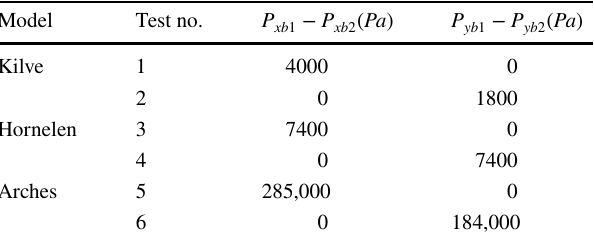
Table 3 Water flooding scenarios for which saturation functions were obtained Model